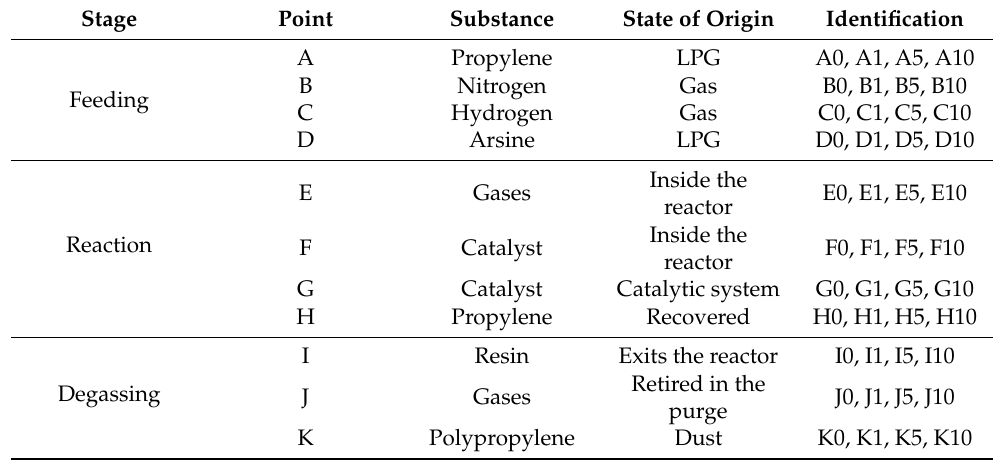
Table 2. Identification and sampling